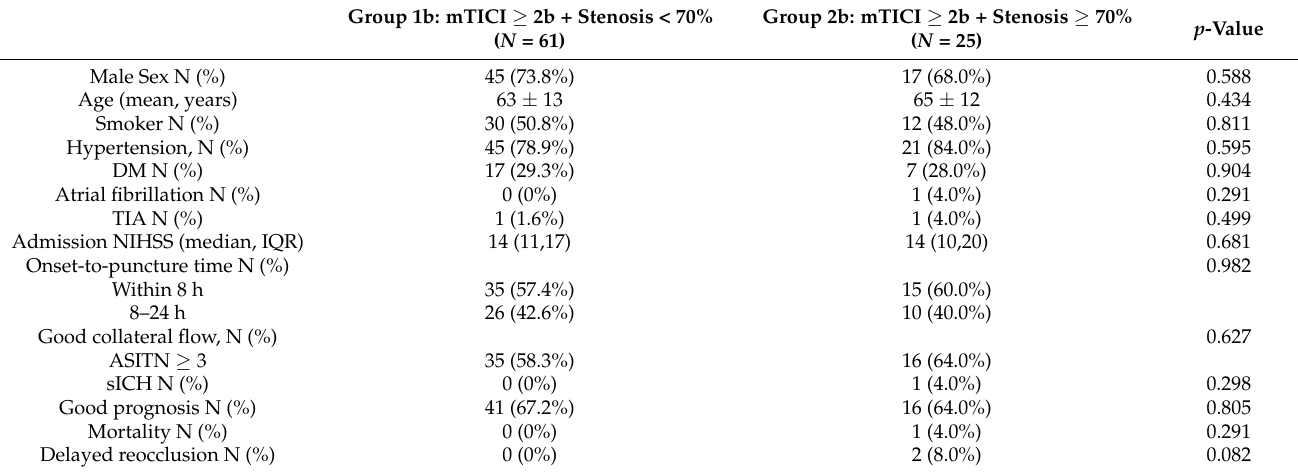
mTICI, modified thrombolysis in cerebral infarction; DM, diabetes mellitus; TIA, transient ischemic attack; NIHSS, National Institutes of Health Stroke Scale; IQR, interquartile range; ASITN, American Society of Interventional and Therapeutic Neuroradiology collateral grading system; sICH, symptomatic intracranial